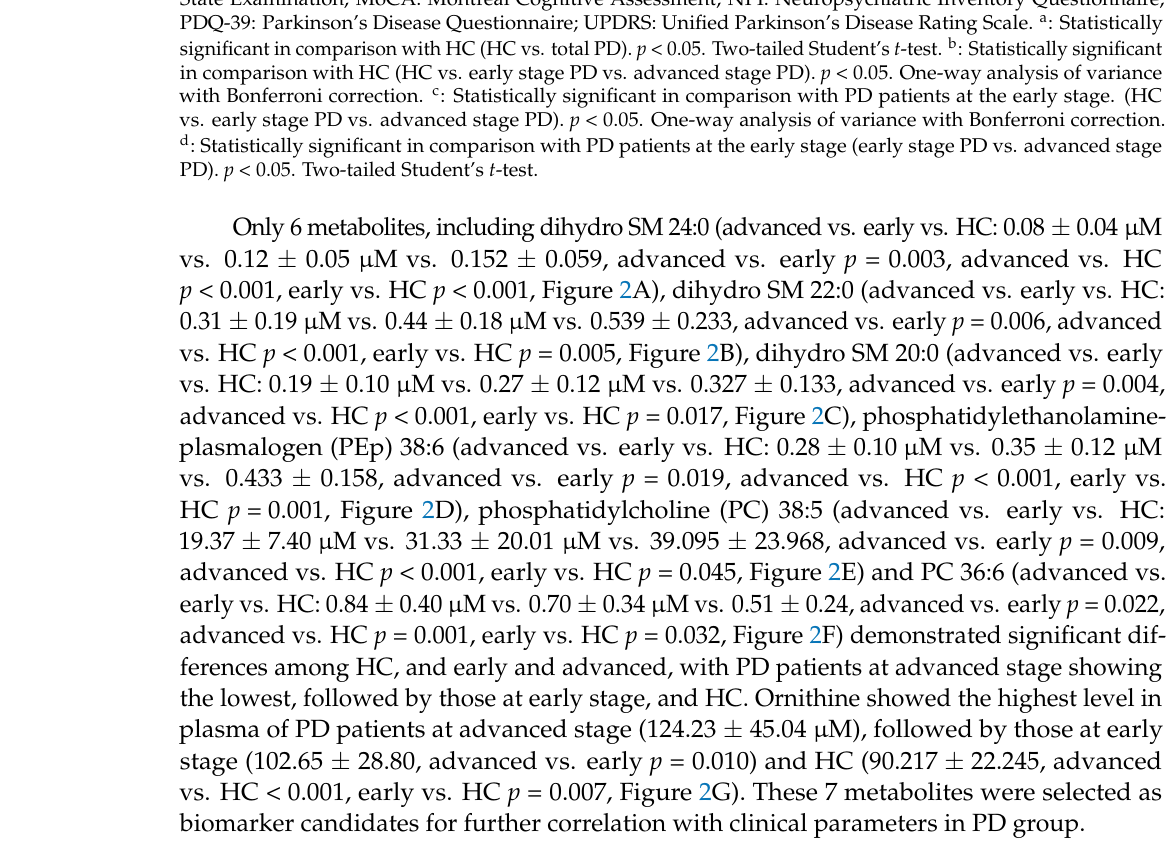
d : Statistically significant in comparison with PD patients at the early stage (early stage PD vs. advanced stage PD). p < 0.05. Two-tailed Student’s t -test. Only 6 metabolites, including dihydro SM 24:0 (advanced vs. early vs. HC: 0.08 ± 0.04 µ